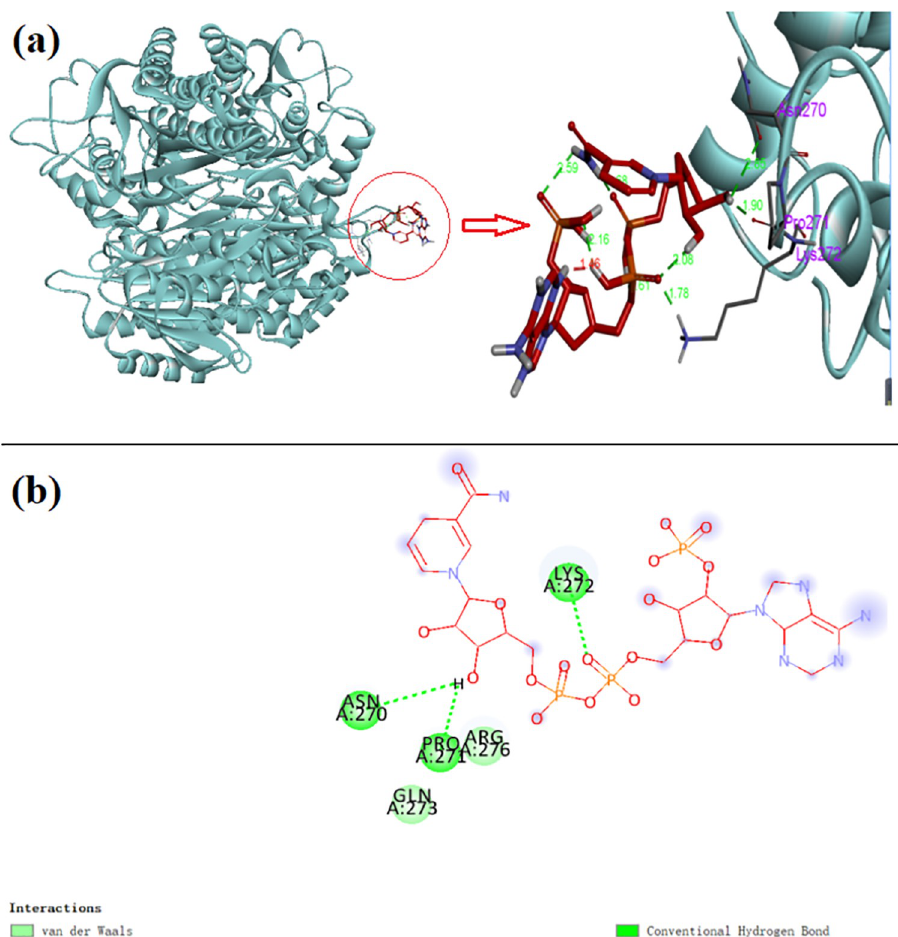
Fig 8. Molecular docking of the AKR with NADPH. (a) The AKR molecular docking model; (b) The AKR molecular docking local